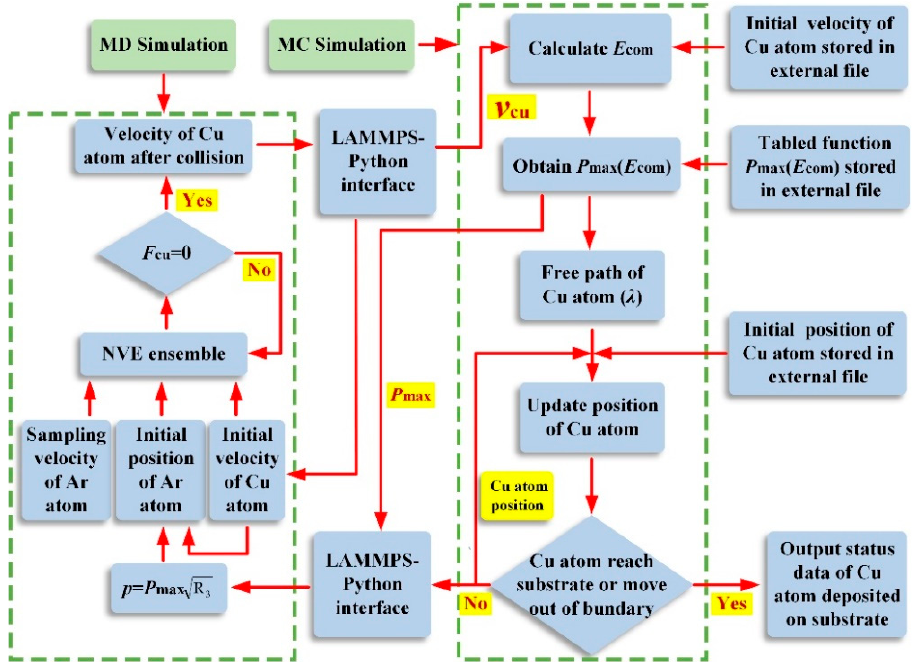
Figure 4. The flow charts of the MC-MD coupled simulation.